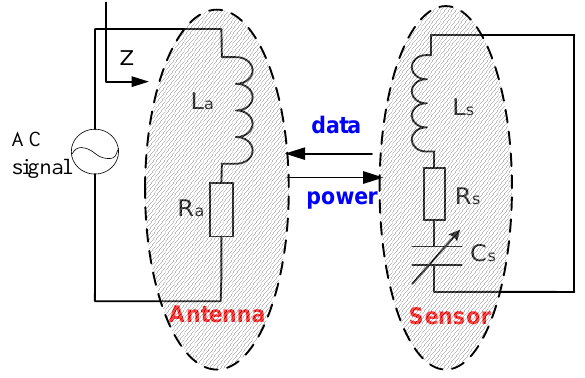
Figure 4. Model of the sensor-antenna